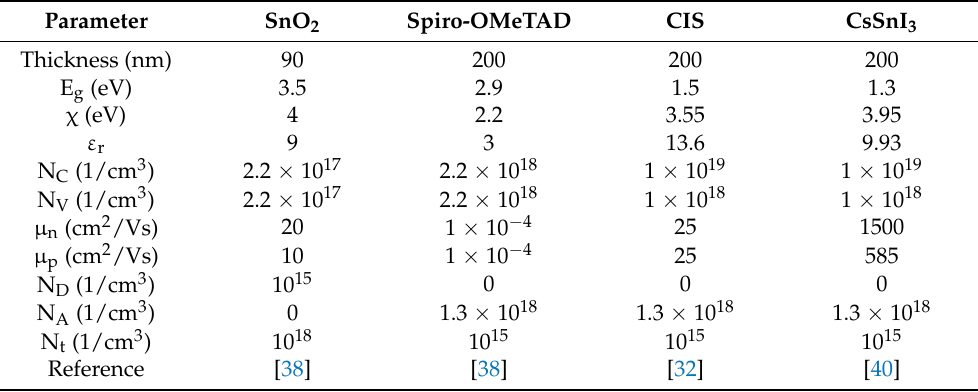
Table 2. Characteristics of ETL and HTL used for